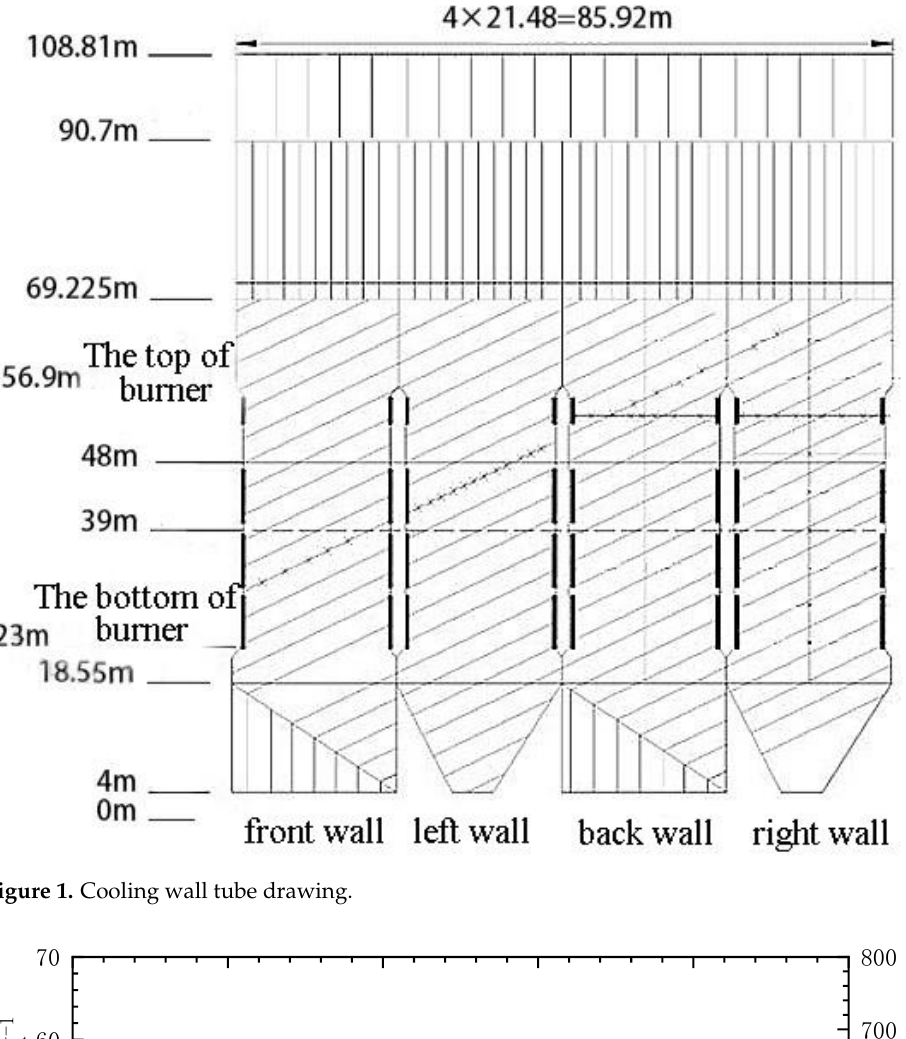
Figure 1. Cooling wall tube drawing.